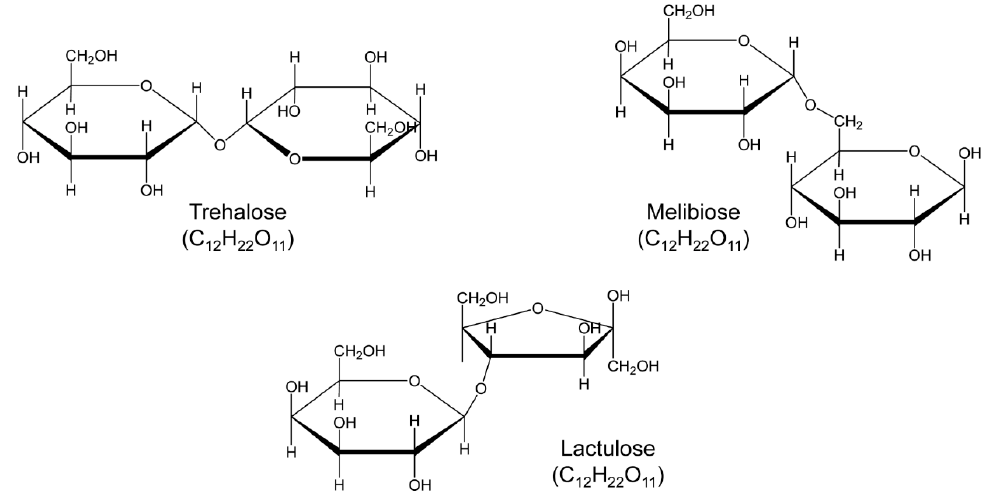
Figure 1. Structure of the studied trehalose and analogs, lactulose and melibiose (formula C 12 H 22 O 11 , molar mass 342.30).